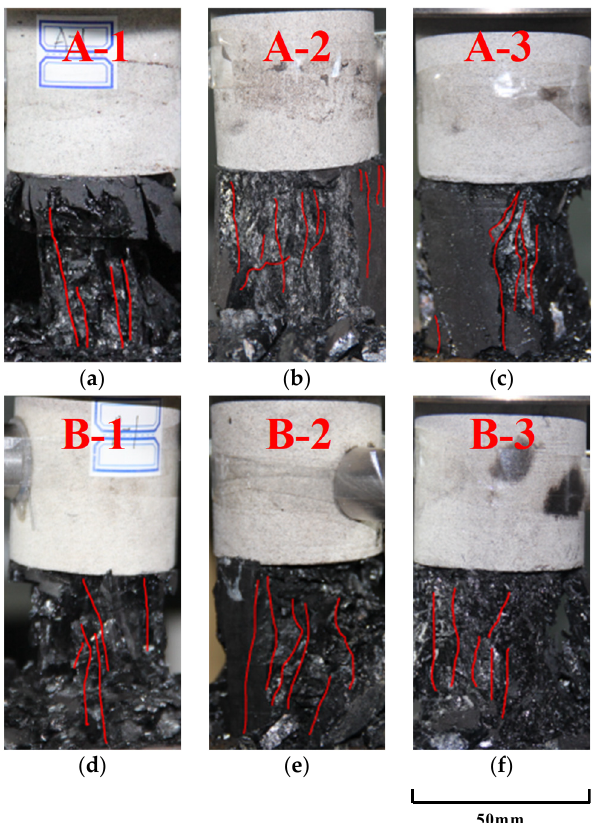
Figure 16. Macro-failure patterns of composite samples (the scale bar between the sample size in the figure and that of the real sample is 1:2): ( a ) Macro-failure pattern of A-1 composite sample; ( b ) Macro-failure pattern of A-2 composite sample; ( c ) Macro-failure pattern of A-3 compo- site sample; ( d ) Macro-failure pattern of B-1 composite sample; ( e ) Macro-failure pattern of B-2 com- posite sample; ( f ) Macro-failure pattern of B-3 composite sample.